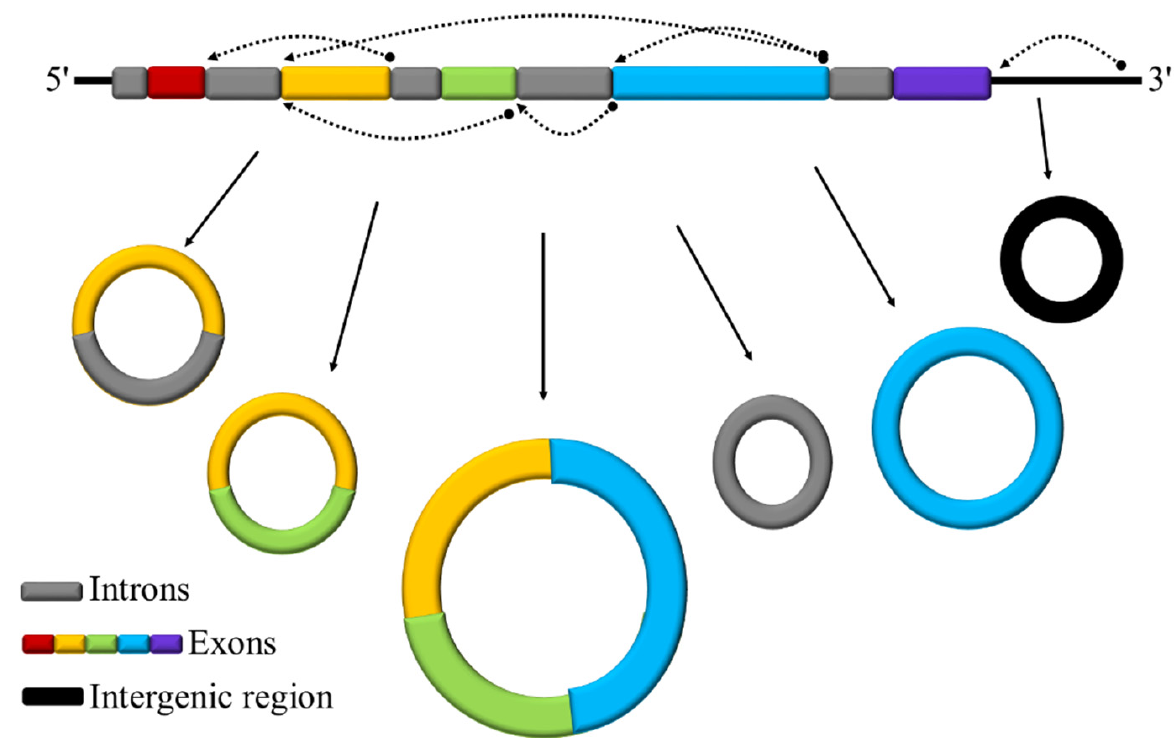
Figure 1. A schematic representation of back-splicing producing basic types of circRNAs from different genomic regions. Dashed curved arrows represent back-splicing junctions.